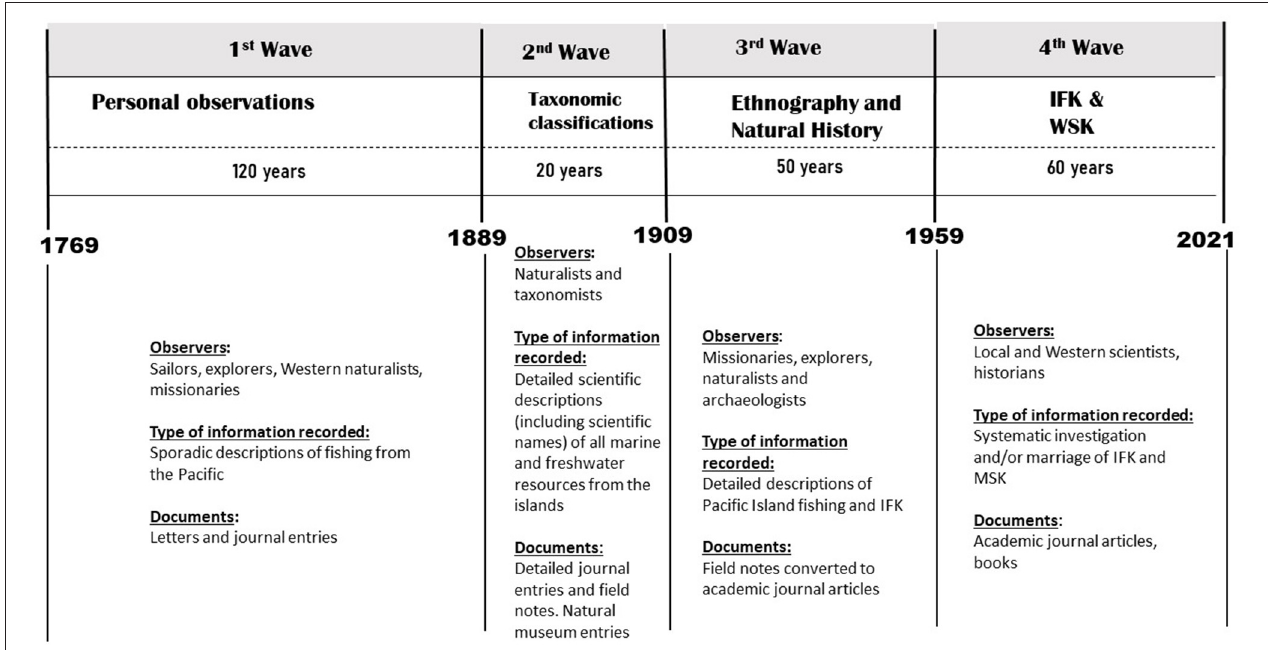
FIGURE 3 | Progression of the four waves of indigenous fisher knowledge documentation in Fiji and other Pacific